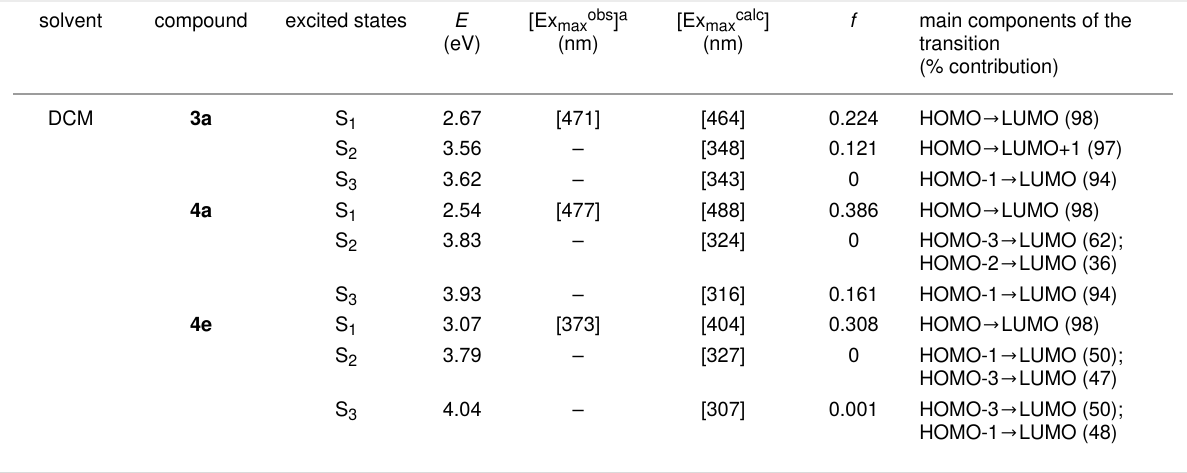
Table 4: Calculated excitation energies ( E [Ex max ]), oscillator strengths ( f ), and main components of the transition of the three lowest excited states for compounds 3a , 4a , and 4e using the TD-B3LYP/6-311+G(d,p)//B3LYP/6-31G(d,p) level of theory. solvent compound